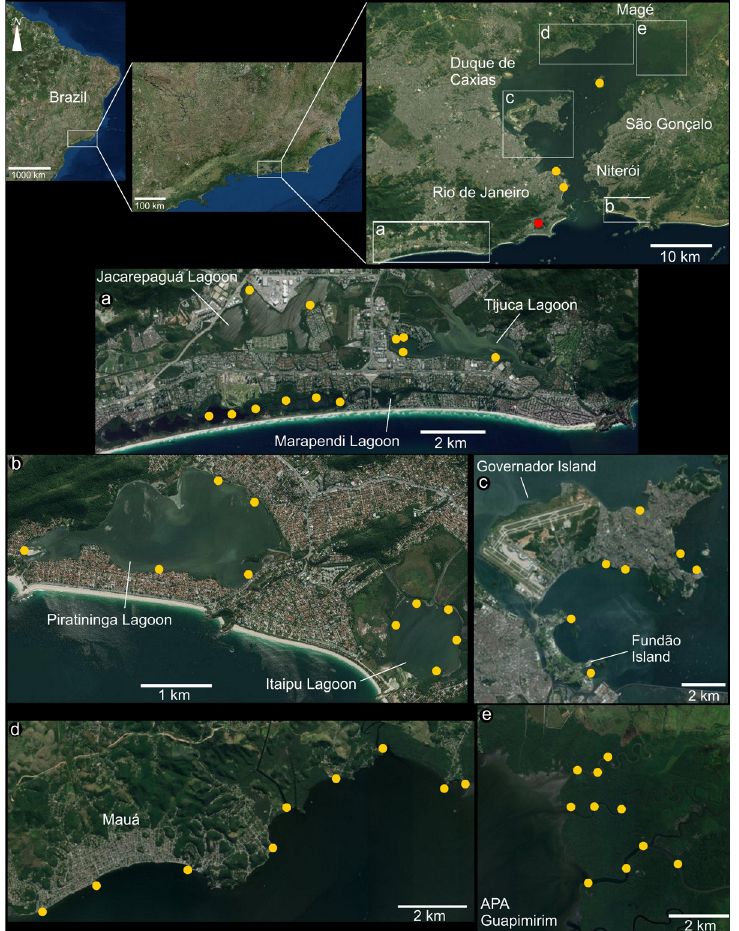
Figure 1. Investigated sites (yellow dots) in the metropolitan region of Rio de Janeiro. The red dot indicates the previously known invasive population of Mytilopsis leucophaeata in Rodrigo de Freitas Lagoon. Map adapted from